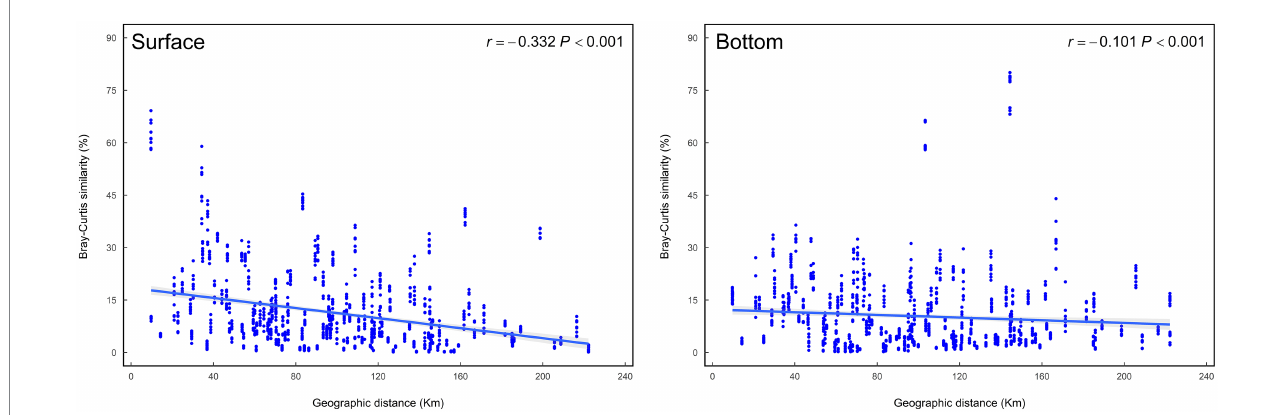
FIGURE 6 Distance-decay curves showing Bray–Curtis similarity among eukaryotic plankton communities against geographic distances among sampling sites.